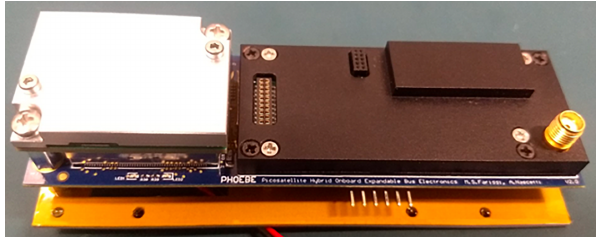
Figure 17. PHOEBE board, (Credits to School of Aerospace